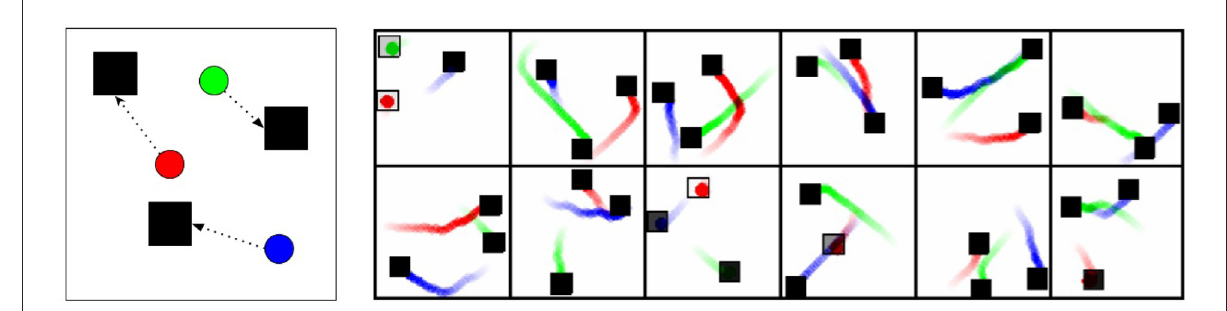
FIGURE7 Cooperative navigation environment and behavior. The Cooperative Navigation environment has three targets (black squares) and three agents (circles). The agents must coordinate to cover all targets. (Left) Illustration of environment and potential solution. (Right) Traces of the testing behavior from the learned MASAC policies. The actions were reduced in magnitude to create slow paths to the targets. Some targets appear as outlines, showing that the agent happened to start on or near that target. The traces are interesting in that they show clear coordination but occasionally sub-optimal pairings of entities and targets. If the actions were not reduced, such that the entities reached the targets in only a handful of steps, these sub-optimalities would have little consequence on score.